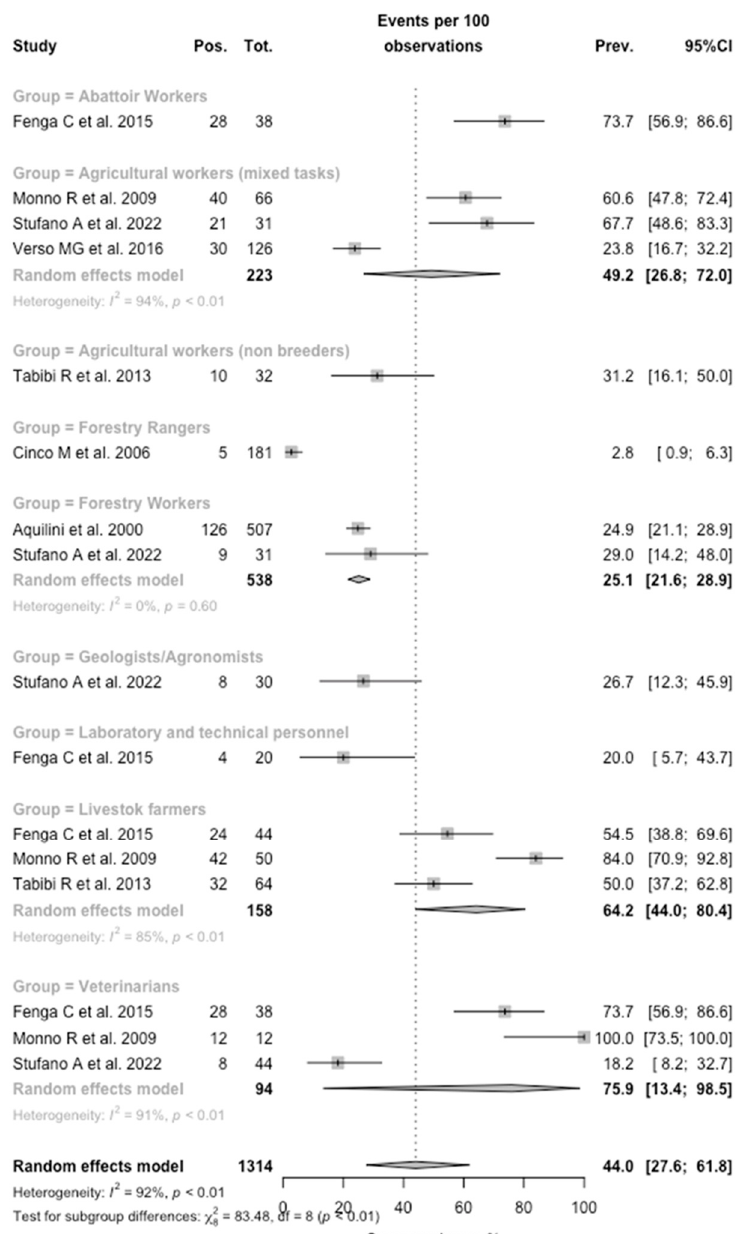
Figure 3. Forrest plot for retrieved seroprevalence studies about C. burnetii infection in Italy, from occupational settings. A pooled seroprevalence of 44.0% (95% Confidence Interval [95%CI] 27.6 to 61.8) was eventually calculated, with substantial heterogeneity (tau 2 = 2.004; tau = 1.4157; I 2 = 92.4% [95%CI, 89.3%; 94.6%], Q = 197.88, p < 0.001)